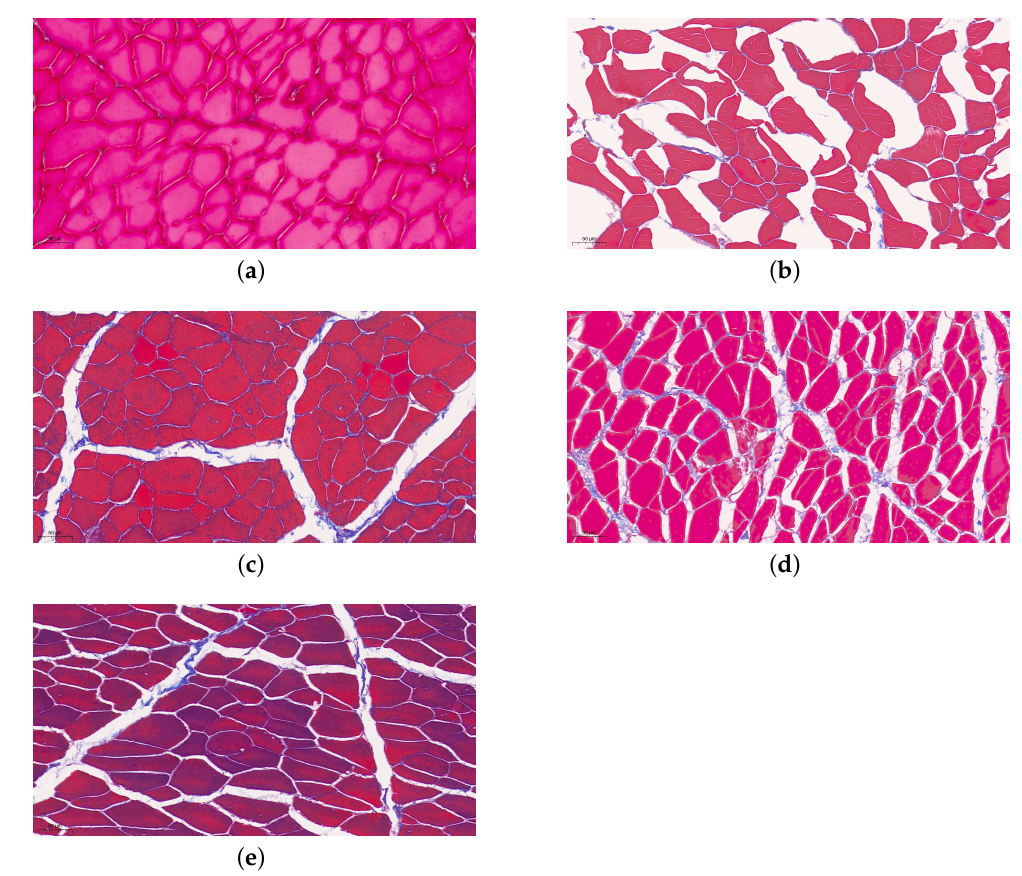
Figure 4. Masson staining results show the changes of muscle fibers in Jinhua ham from raw ham to finished stage (20 × ). ( a – e ) Identical letters represent the period of raw ham, post-salting stage, the medium term of ripening, the latter stage of ripening and the one-year-old hams respectively